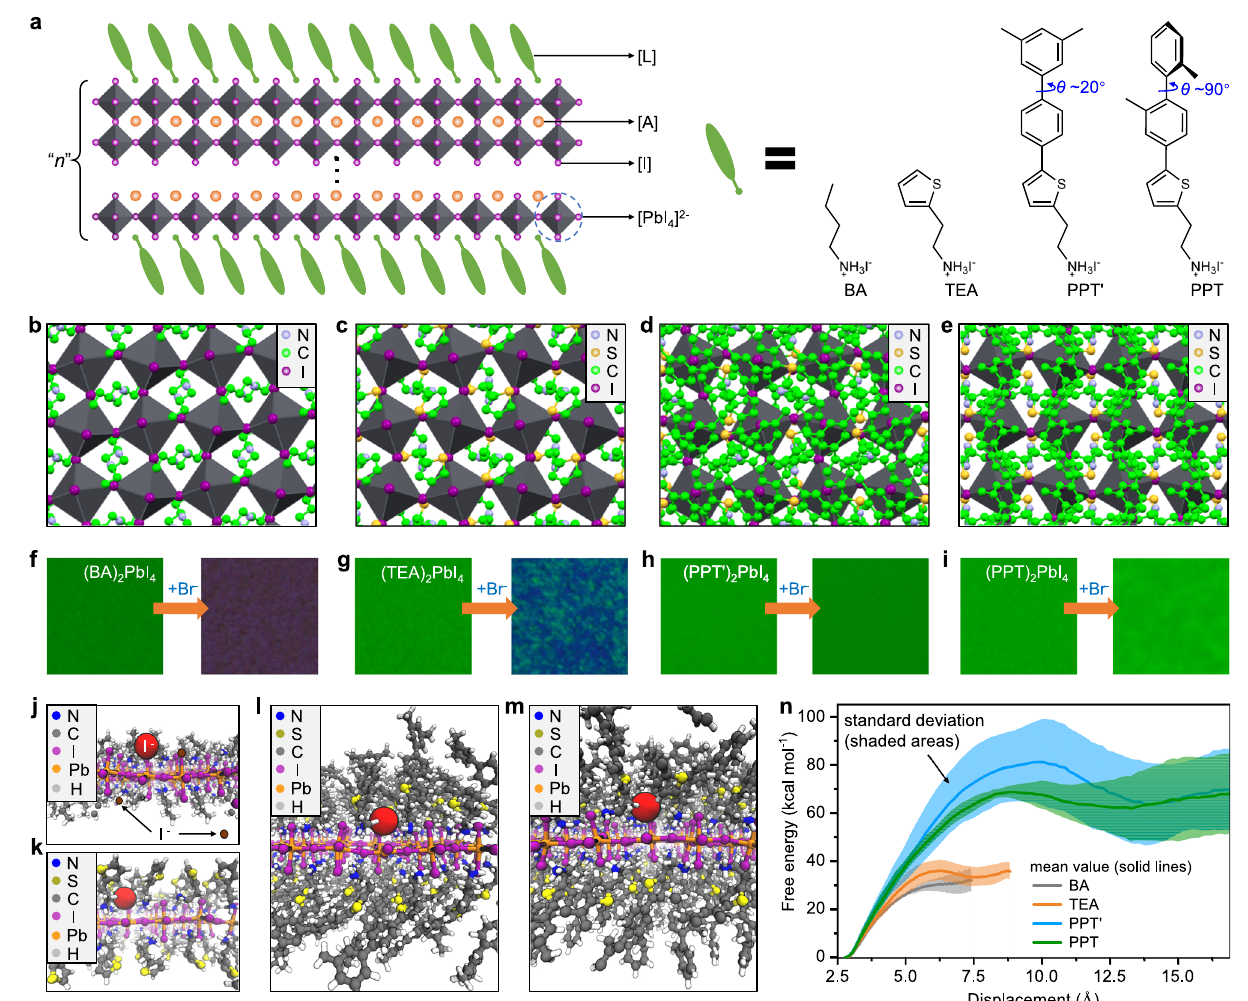
Fig. 1 | Blocking ionic transport in 2D perovskites by bulky organic ligands. a The schematic illustration for the general structure of quasi-2D perovskites and the chemical structures of large organicligands, BA, TEA,PPT ’ , and PPT,studied in this work. The two methyl groups at PPT ligand were designed to induce steric hindrance and break the planarity of the ligand, thus leading to an increased dihedral angle θ of ~90°. b – e The top view of the single crystal structure of (BA) 2 PbI 4 ( b ), (TEA) 2 PbI 4 ( c ), (PPT ’ ) 2 PbI 4 ( d ), and (PPT) 2 PbI 4 ( e ). Black diamonds represent inorganic octahedral